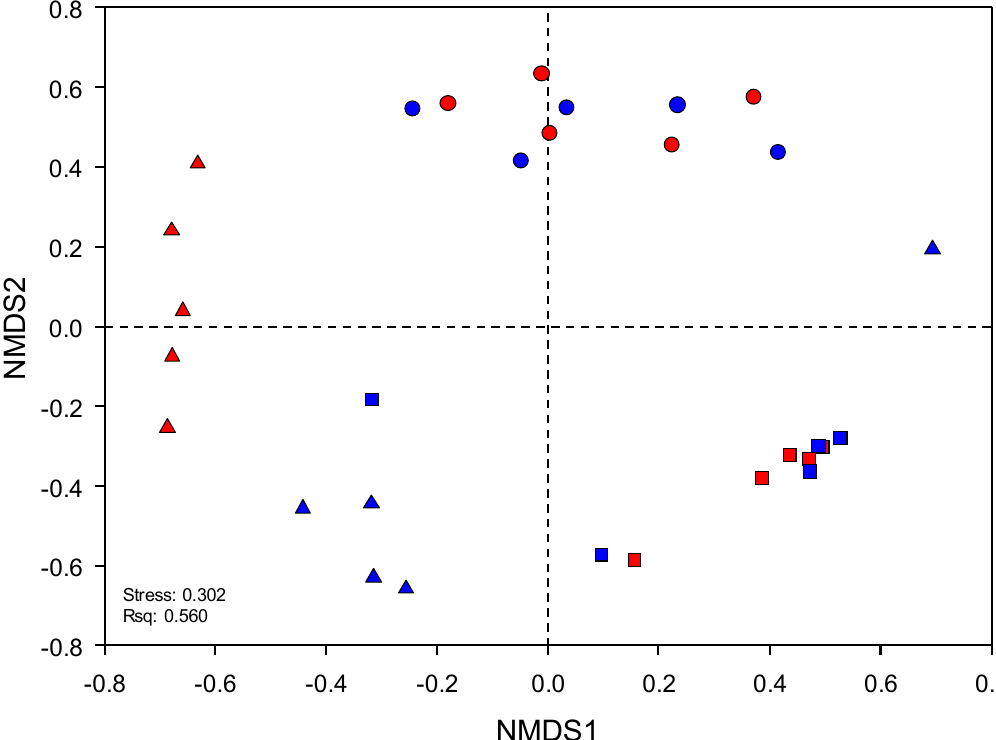
Figure 1. Microbial community profiles of the samples from Hwaseong (circles), Daegu (squares), and Bonghwa (triangles) based on non-metric multidimensional scaling (NMDS) using the Mothur package. Distance matrix was calculated using the Yue and Clayton theta supplied in the Mothur package. Operational taxonomic units (OTUs) were determined based on 3% dissimilarity of nucleotide sequences. Blue and red denote surface and subsurface, respectively.